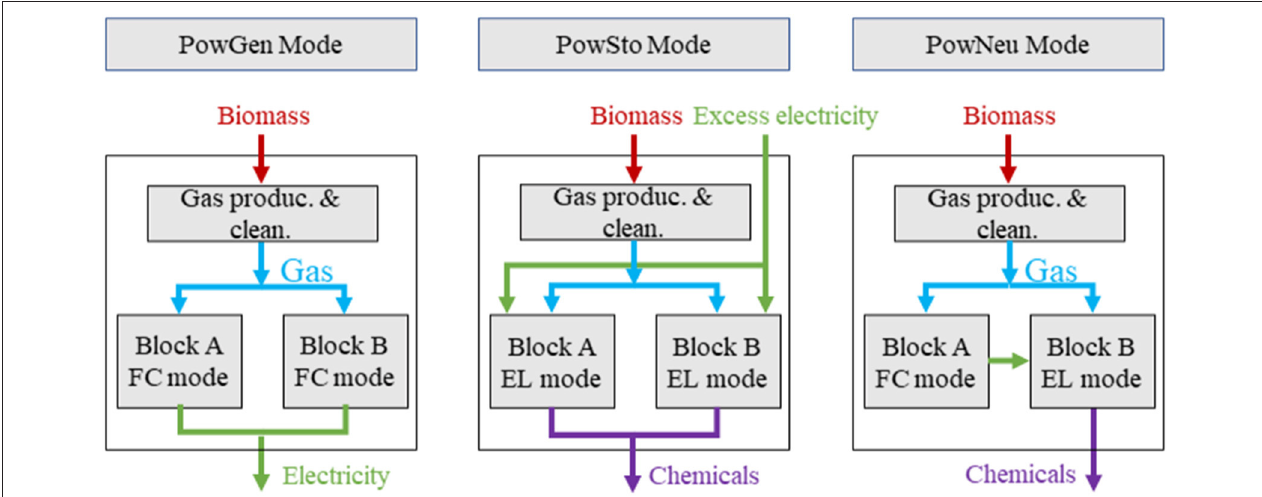
FIGURE 2 | The generic concept of W2G plant (Wang L. et al., 2020). The chemical produced in the PowSto and PowNeu modes is synthesis natural gas, due to the existing large infrastructure.